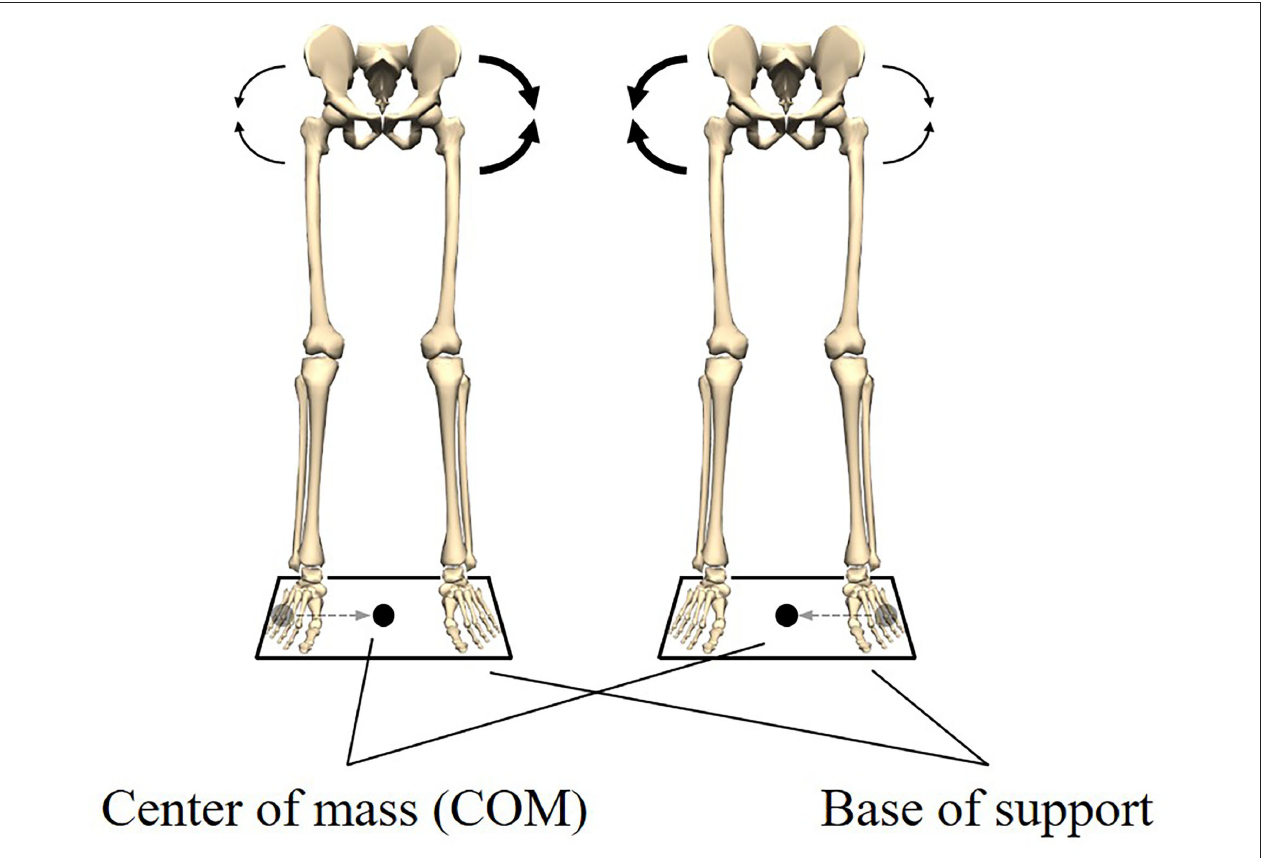
FIGURE 1 | Postural stability in the left-right direction during quiet standing. Keeping the center of mass (COM) within the base of support is a functional requirement to maintain quiet standing. The functional requirement is met by the coordination of the left and right hip abductors/adductors moments. When the COM is located at the left end of the base of support, the right abductor moment increases and the left abductor moment decreases. Also, when the COM is located at the right end of the base of support, the left abductor moment increases and the right abductor moment decreases. This relationship between the moments allows the COM to be kept within the base of